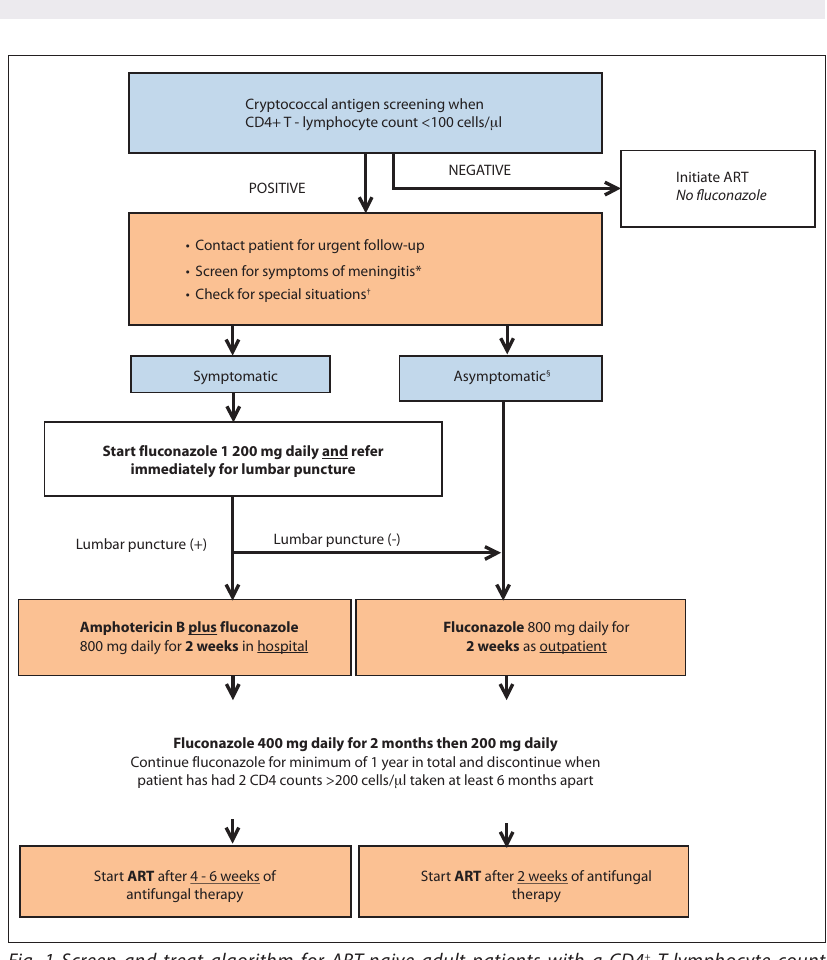
Fig. 1 Screen-and-treat algorithm for ART-naive adult patients with a CD4 + T-lymphocyte count <100